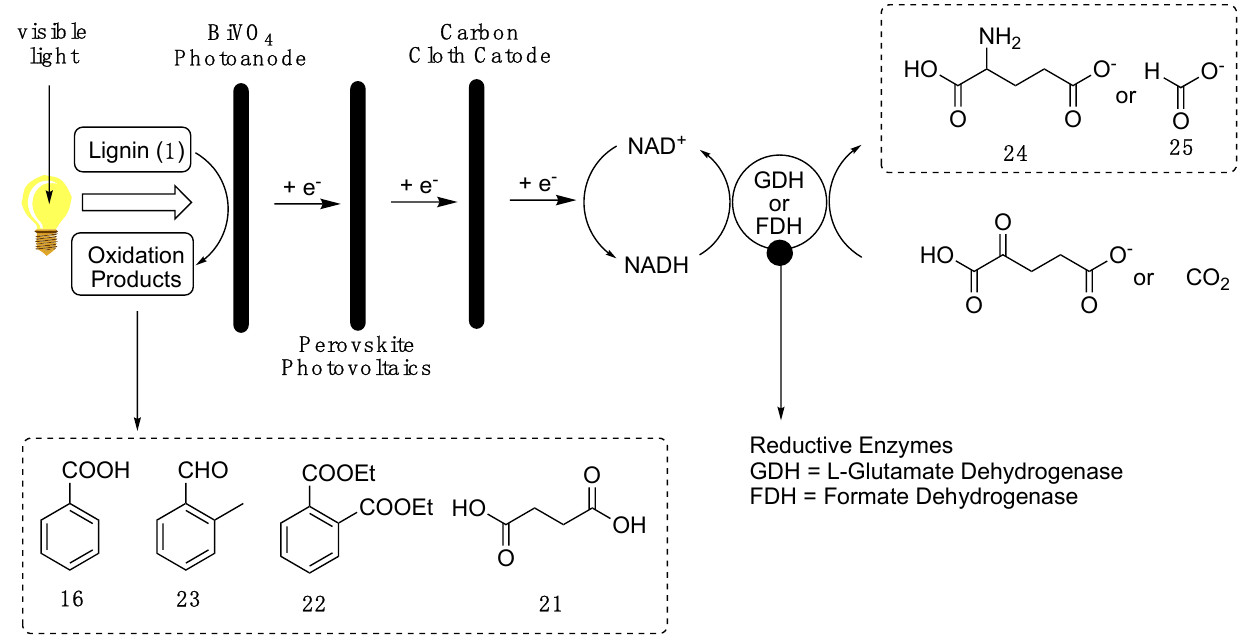
Figure 3. Schematic representation of the photoelectrochemical platform. The oxidative reaction was performed on alkali lignin and lignosulfonate lignin for 12 h and was monitored by 2D-NMR and gel permeation chromatography. Depolymeri- zation of lignin was demonstrated by the decrease in molecular weight of the alkali lignin from 51,000 to 15,000. At the same time the NMR spectrum evidenced a breakage of the linkages with low bond dissociation energies, such as the β-O-4 linkage. It is worth men- tioning, the two samples of lignin gave different results. When the oxidation was per- formed on lignosulfonate, the disappearance of the absorption bands of the aromatic re- gion and an appearance of signals of the C=O stretching bands was observed by FTIR. This suggests that the oxidation is able to open the aromatic rings to carbonyl groups. On